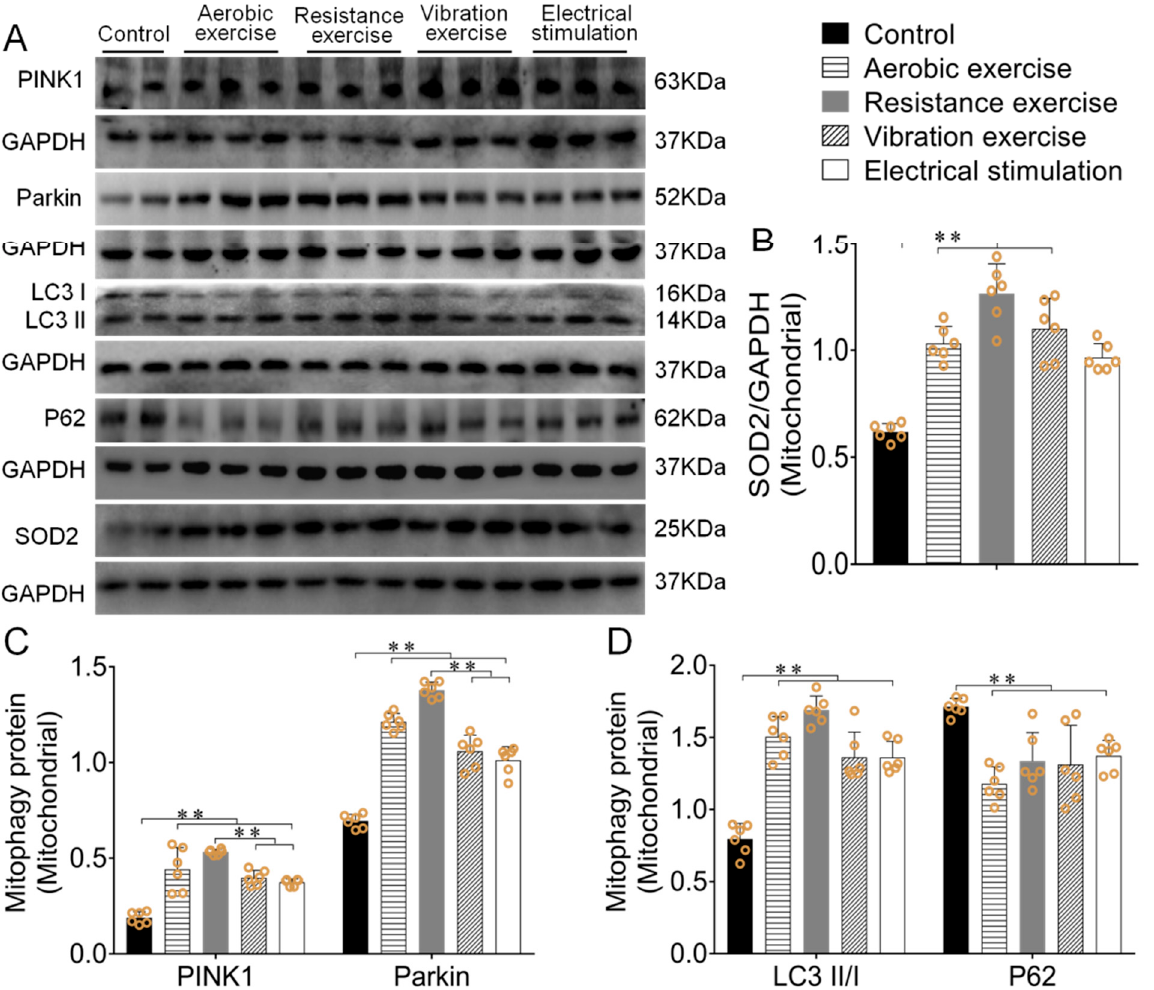
Figure 4. Different types of exercise and skeletal muscle electrical stimulation intervention activated mitophagy in mito- chondria and enhanced antioxidant function. ( A – D ) The effect of mice’s myocardial mitochondrial PINK1, Parkin, P62, SOD2 and LC3II/I ratio after different types of exercise and skeletal muscle electrical stimulation intervention. Data are expressed as mean ± SEM ( n = 6). ** p < 0.01. Abbreviations: PINK1: PTEN-induced kinase 1; Parkin: E3 ubiquitin ligase parkin; LC3II/I: microtubule-associated protein light chain 3; P62: SQSTM1/p62, SOD2: superoxide dismutase 2.